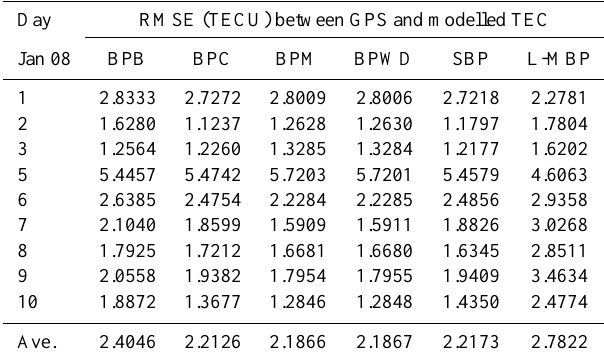
Table 4. Computed RMSE values for the first 10 days in Jan- uary 2008 over